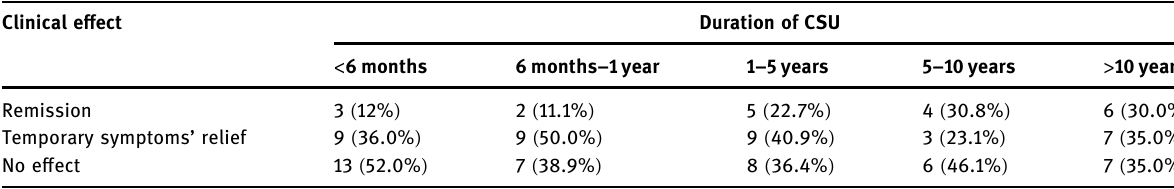
Table 5: Plasmapheresis e ff ect depending on duration of CSU Clinical e ff ect